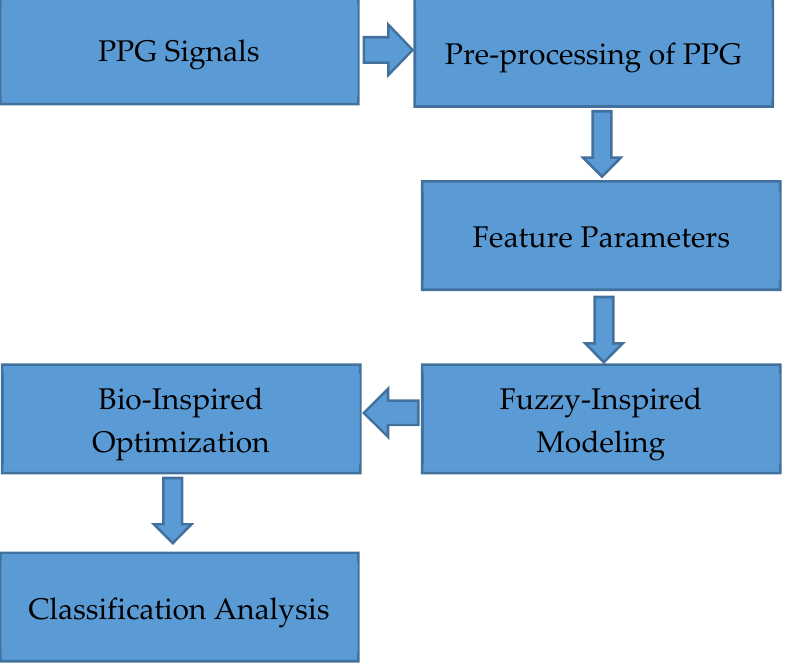
Figure 1. Block diagram of the work.